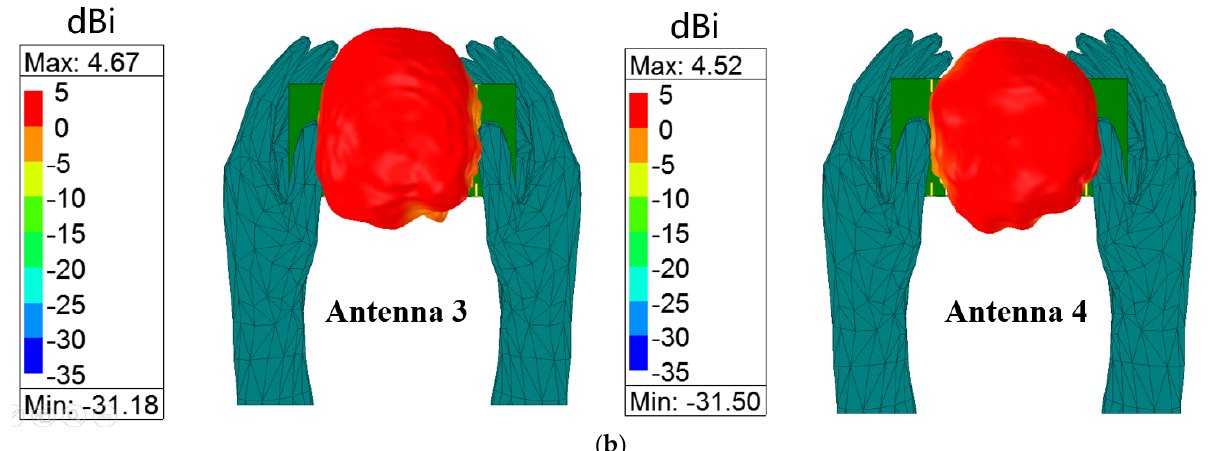
Figure 8. The simulated 3D radiation pictures of ( a ) Ant. 3 and Ant. 4 operate at 3.4 GHz; ( b ) Ant. 3 and Ant. 4 operate at 4.9 GHz.